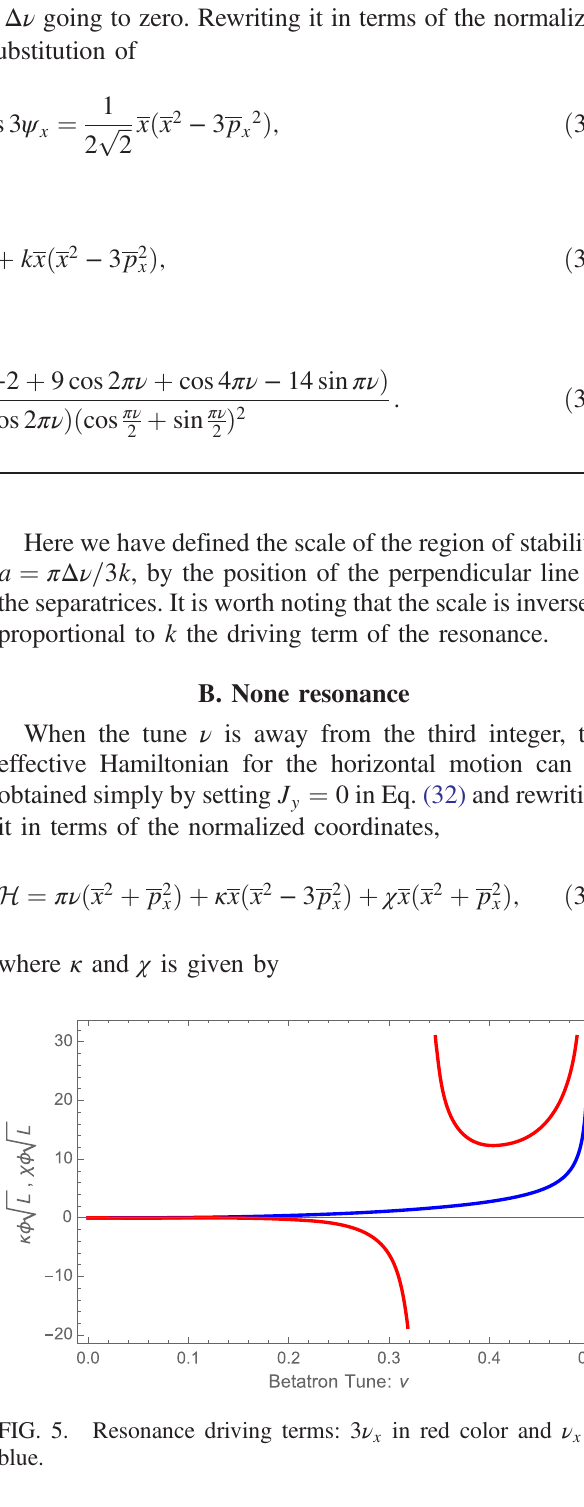
in red color and ν in x x